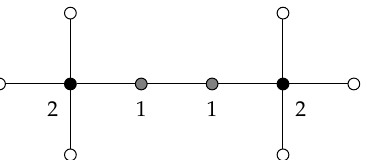
Figure 3. The labels of (gray and black) coloured vertices describe the positive weights of a γ qtR ( G )